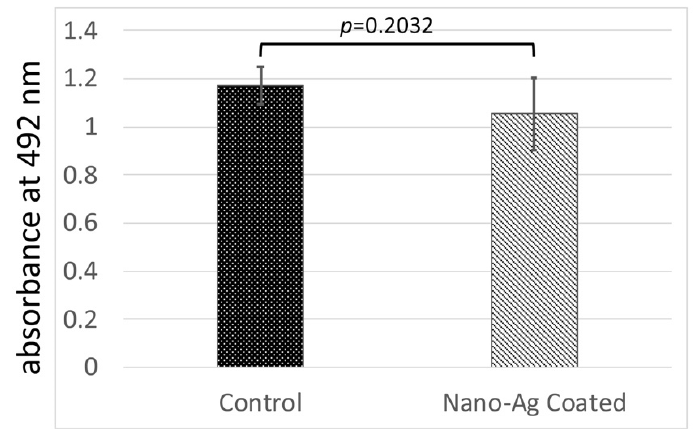
Figure 5. The cell proliferation assay of well plate after 72 hours of incubation without medium change. Error bars represent mean ± standard deviation for n = 5. The one-way analysis of variance and t -test comparisons were used for parametric analyses. There was no statistically significant difference between control and nano-Ag coating.